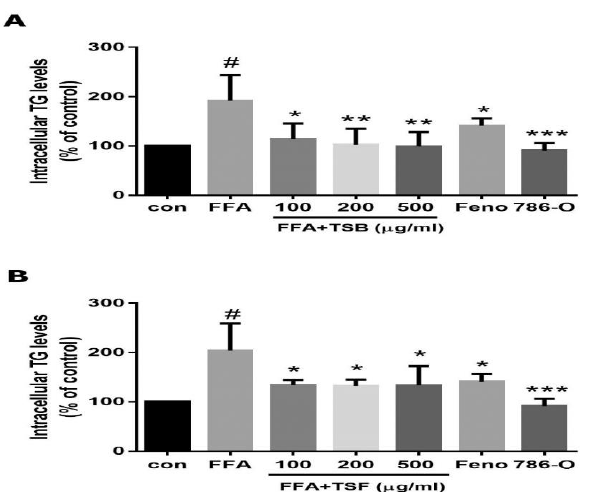
Figure 4. Effects of TSB ( A ) and TSF ( B ) extracts on FFA-induced intracellular triglyceride levels. Fenofibrate (Feno, 125 µ M) was used as a positive control. In renal carcinoma cells, 786-O served as a negative control. The bar graphs show the quantification of the triglyceride contents. Data from six independent experiments are expressed as mean ± SD. # P < 0.05 compared with the control group (con). * P < 0.05, ** P < 0.01, *** P < 0.001 compared with the FFA group. (please add the sentence after * P <